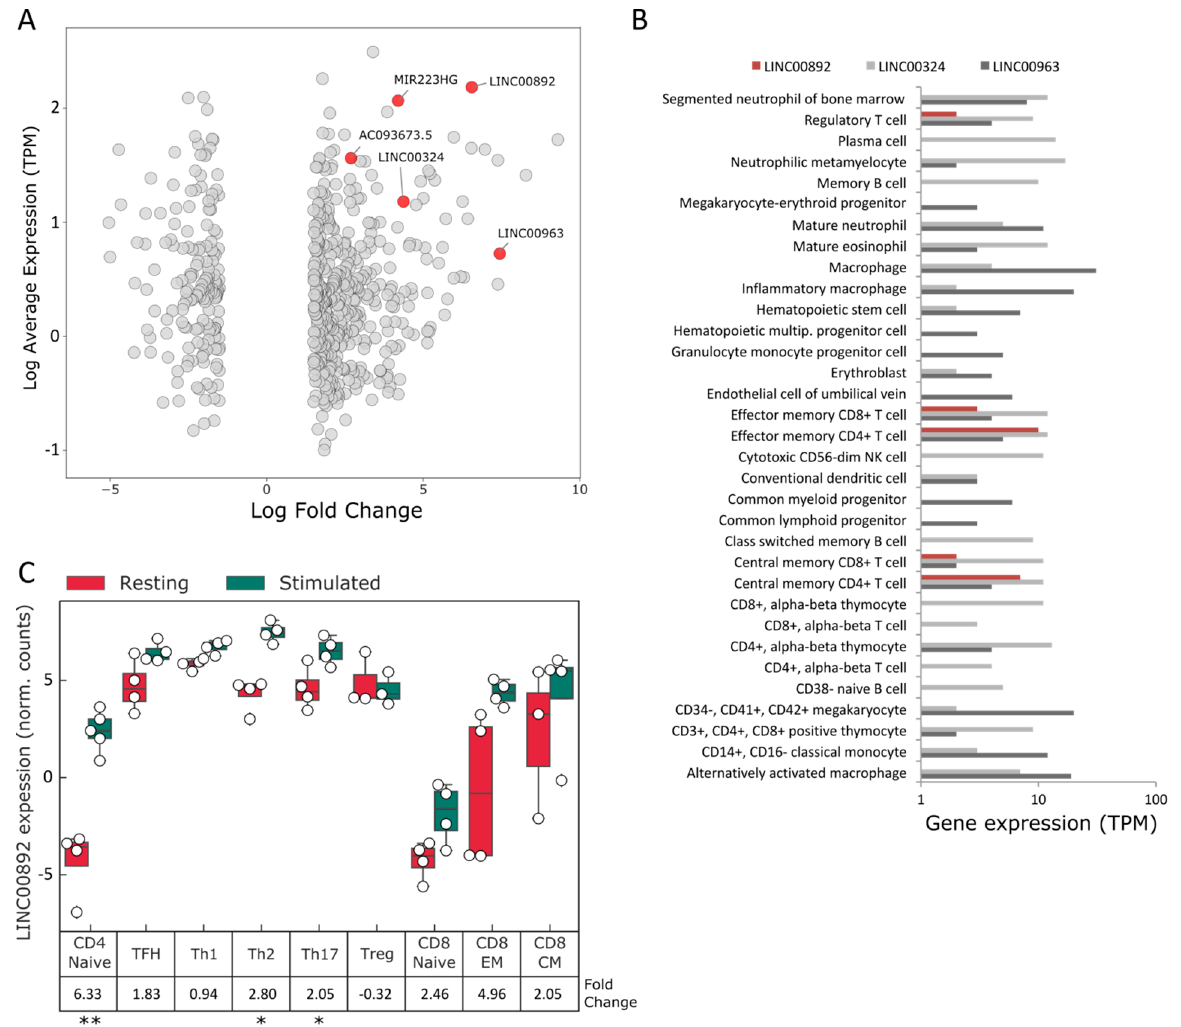
Figure 1. Expression analysis of lncRNAs differentially expressed in Jurkat cells and in FL samples. ( A ) mean-difference (MD) plot of lncRNAs differentially expressed in the comparison of NS with SW4D Jurkat cells. The graph highlights the fold changes in expression of lncRNAs with high expression level (defined in TPM). LncRNAs also differentially expressed in the same direction in FL samples are depicted in red and labeled with their names. ( B ) Gene expression analysis of the three indicated lncRNAs in cells from peripheral blood. The analysis has been performed on data provided by the Blueprint project and downloaded from the Expression Atlas portal of the European Bioinfomatics Institute. ( C ) Analysis of LINC00892 expression in resting conditions and 24 h after treatment with anti-CD3/CD28 beads (stimulated) in different subsets of primary T cells, using the RNA-seq data published by Calderon and colleagues [29]. LINC00892 expression is shown as normalized counts. For each cell line, the log of the fold change (in the comparison of stimulated vs. resting) is shown. Expression analysis has been performed using data from 4 different samples. * p -value < 0.05; ** p -value < 0.01.